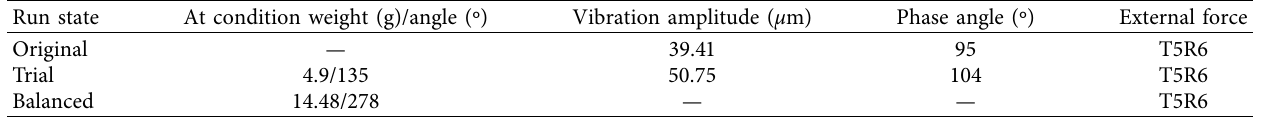
Table 11: Rotor balancing results using BSS-ICM with external force.